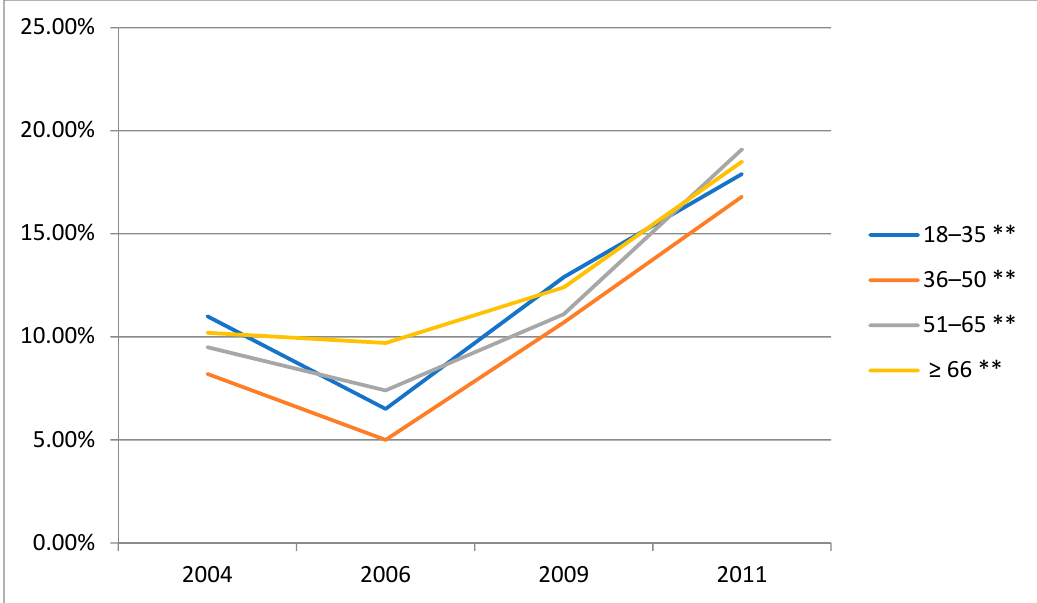
Figure 2. Time trends in the prevalence of alcohol consumption (beer) amongst male drinkers by age groups, CHNS. ** Statistically significant ( p < 0.01).